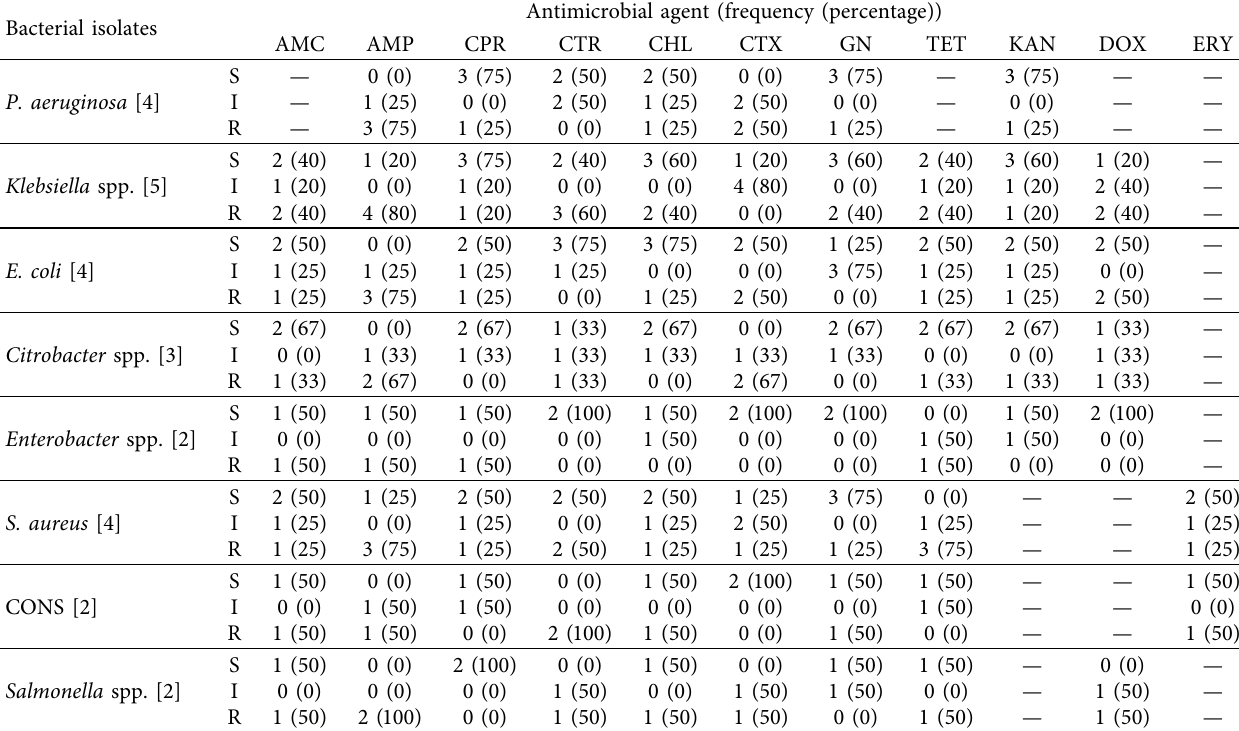
Table 3: Antibiotic susceptibility patterns of bacterial isolates from effluent released from Arba Minch Hospital. Antimicrobial agent (frequency (percentage)) Bacterial isolates